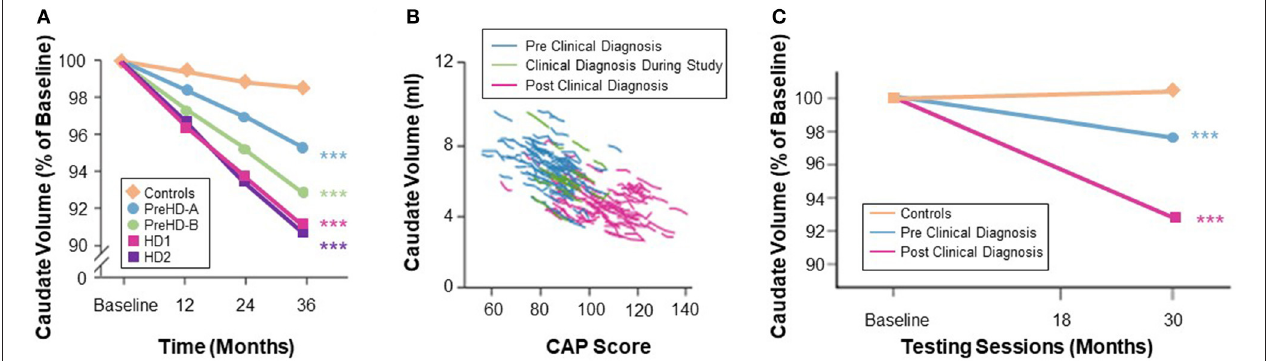
FIGURE 4 | (A) Quantification of caudate volume loss in the TRACK-HD study showed near monotonic change from baseline to 12- and 24-month follow-up across the disease spectrum, with the rate of change increasing after clinical motor diagnosis (3). (B) Change in caudate volume with CAP score from TRACK-HD data (8). (C) Longer follow-up in the IMAGE-HD study also showed a greater degree of longitudinal change in the caudate volume in individuals with a clinical motor diagnosis